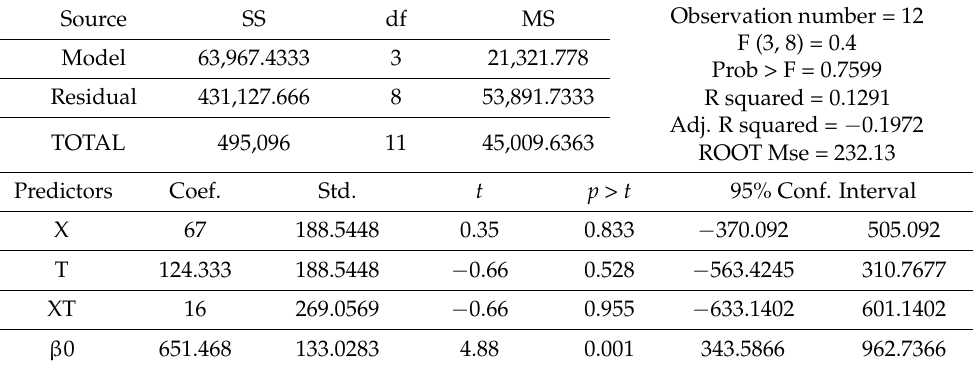
Table 2. Results of DinD data processing on electricity consumption in 330 households in